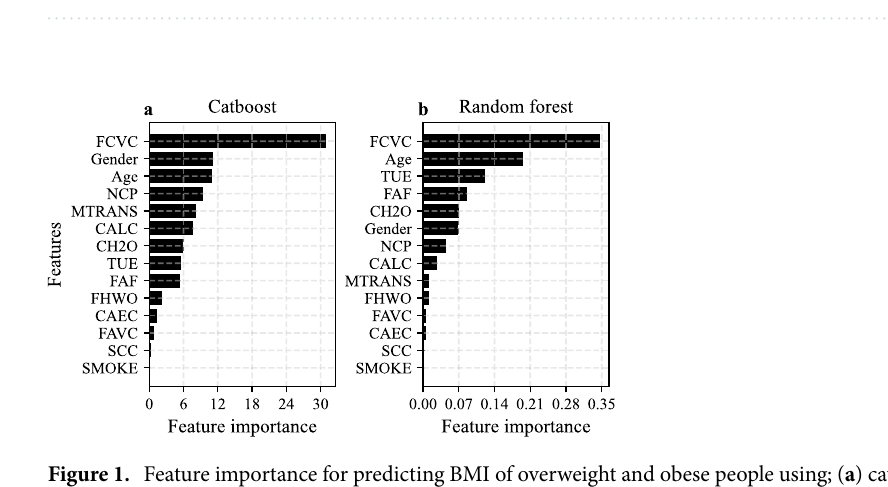
Table 1. Description of characteristics for overweight and obese individuals. Drop in Variance is the test statistic of covariance test. P Value is the p value of covariance test. For continuous features, minimum, maximum, average and standard deviation are displayed. For categorical features, Count is the sample size under each category.